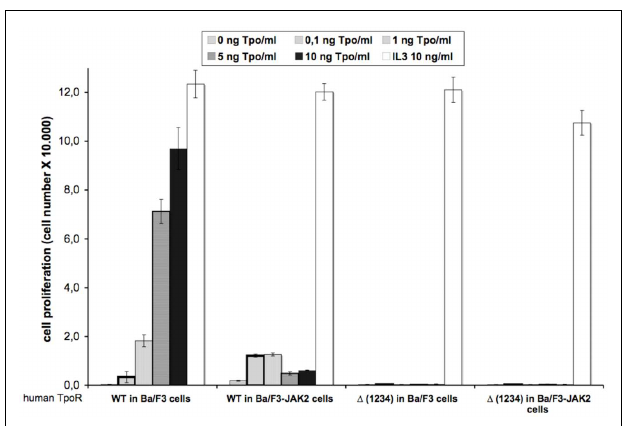
FIGUREA1 | Removal of all four N-glycosylation sites dramatically affects theTpo-dependent cell proliferation of humanTpoR in Ba/F3 and Ba/F3-JAK2 cells. Ba/F3 and Ba/F3-JAK2 cells stably expressingWT or Δ (1234) humanTpoR were washed 3 times and seeded in 96-well plates at a density of 3,000 cells/well.The cells were stimulated with differentTpo concentrations, or with 5ngIL3/ml or left unstimulated during 72h.